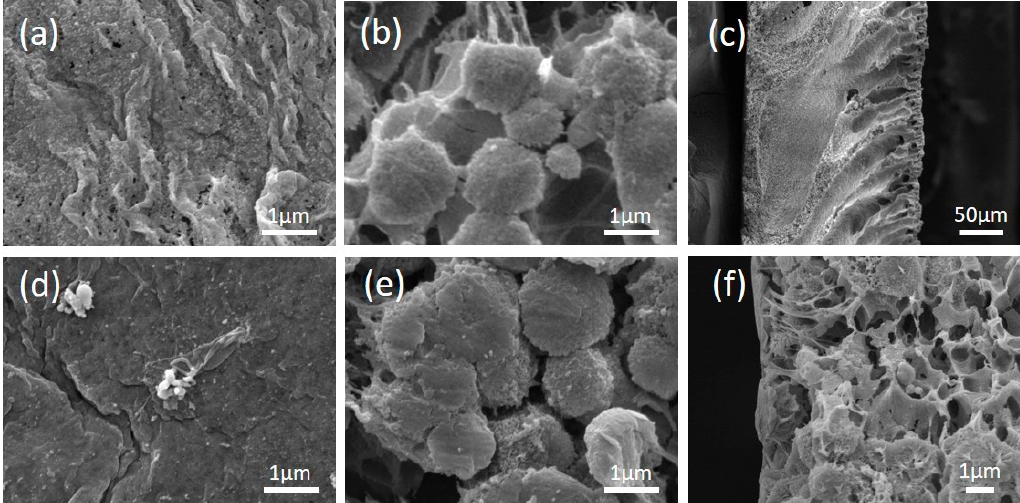
Figure 4. Top view, bottom view, and cross-sectional view of the Original#2 and the modified POMs-M#2 membrane by FESEM: ( a – c ) for images of the Original#2 and ( d – f ) for the modified POMs-M#2, respectively.